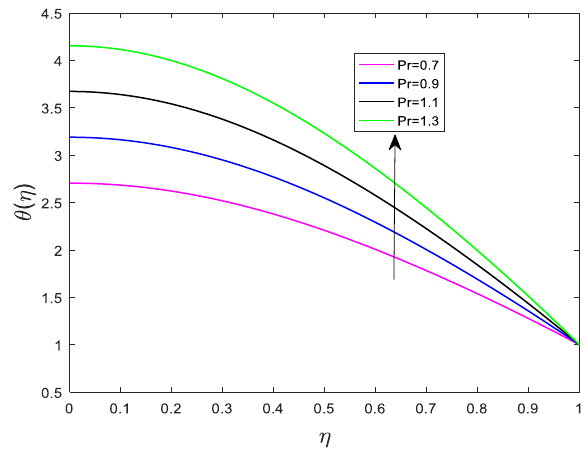
Figure 24: Effect of Pr on θ ( η ) for fixed S = N t = Ec = Kr = 0.1, Ha = N = β = Ω = Ω = 0.5 and Sc = 0.7 T C b